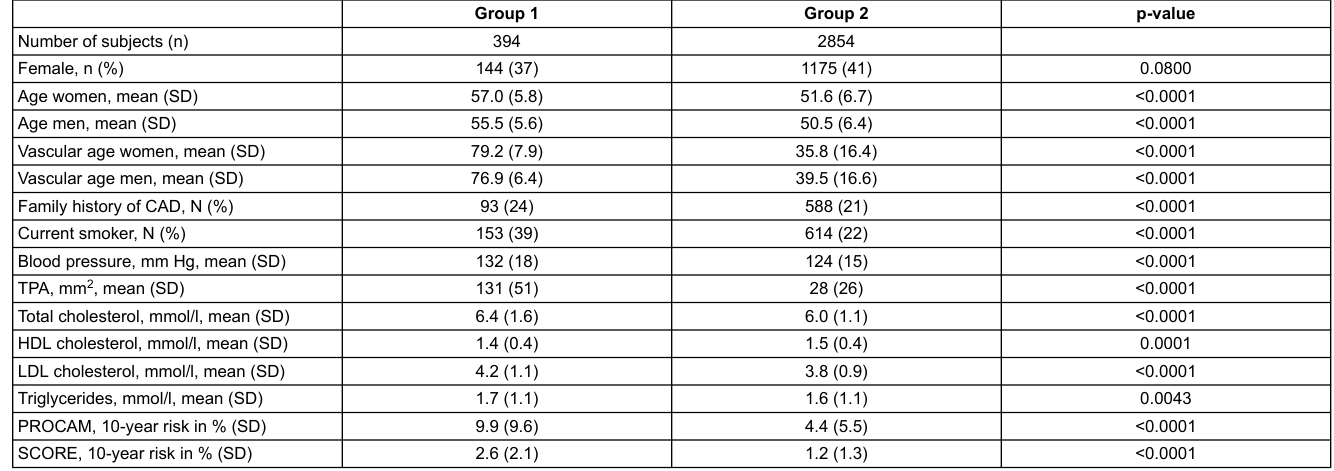
Table 3: Comparison of Group 1 (VA70 present) and Group 2 (VA70 absent).